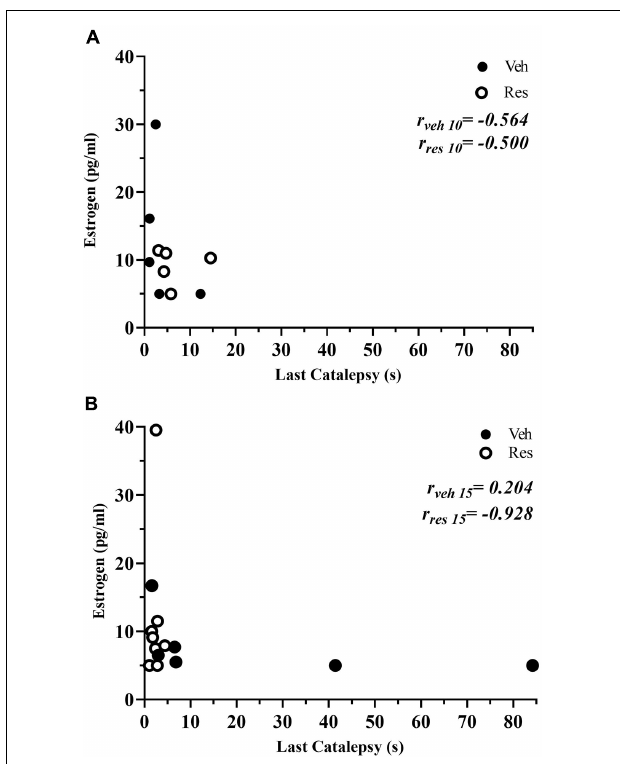
FIGURE 8 | Scatterplots depicting the correlations between the serum estradiol levels and duration of catalepsy of vehicle and reserpine groups that received 10 (A) and 15 injections (B)